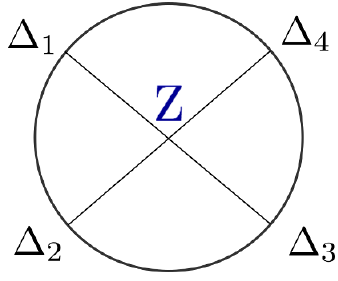
Figure 2 . A contact Witten